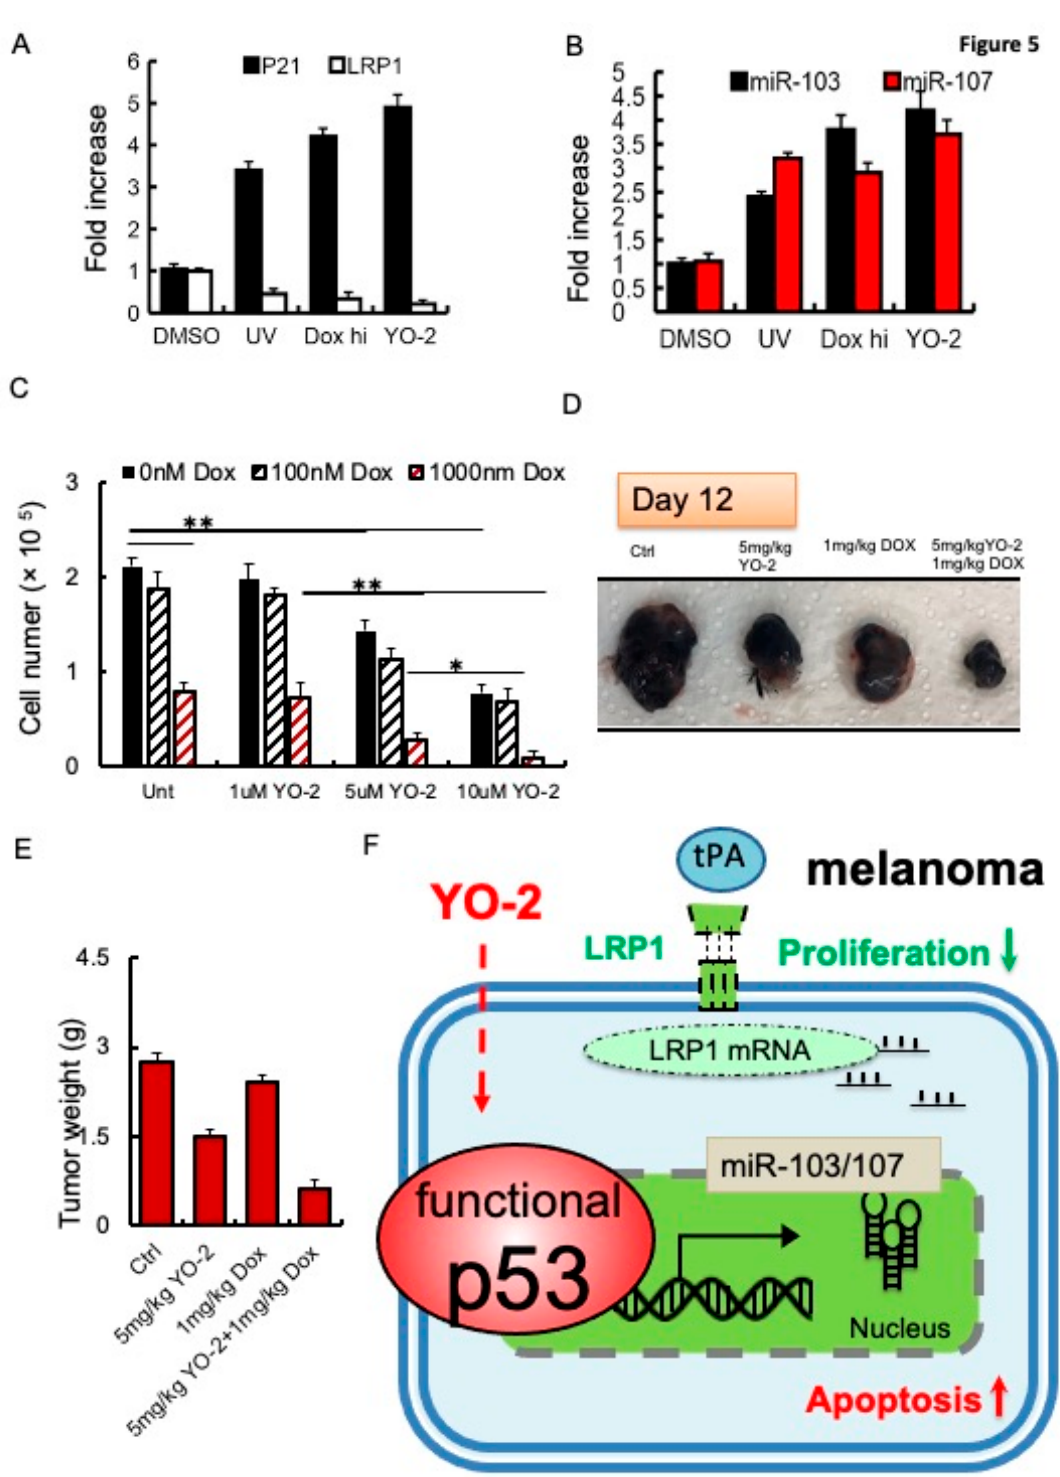
Figure 5. Increased sensitivity of doxorubicin to control tumor growth in YO ‐ 2 ‐ treated tumors. ( A , B ) Fold change in P21 and LRP1 ( A ), and miR ‐ 103 or miR ‐ 107 ( B ) expression in UV ‐ exposed, doxorubi ‐ cin (high) ‐ , and 10 uM YO ‐ 2 ‐ compared to DMSO ‐ treated B16F10 cells ( n = 3/group). We normalized most genes to b ‐ actin. mi ‐ 103 and miR ‐ 107 expression were normalized to U6 gene expression. All data are presented as a relative fold change to controls according to the comparative Ct method (2 −ΔΔ Ct. ) and represented as mean ± SEM, with p values from unpaired Student’s t ‐ test. * p < 0.05, ** p < 0.01. ( C ) The proliferation of B16F10 cells treated with/without YO ‐ 2 in the presence/absence of low (100 nM) and high doxorubicin (1000 nM) ( n = 3/group) as determined by counting cells 24 h after cell plating ( n = 6/group). ( D , E ) B16F10 cells were injected s.c. into the right flanks of C57/BL6 mice. Mice were treated with a single dose of doxorubicin on day 5, and cotreated with/without YO ‐ 2 in the indicated groups every other day starting from day 5. Twelve days after injection, tumor weight was measured ( E ; n = 6/group), and macroscopic tumor images were taken ( D ). * p < 0.05, ** p < 0.01 ( F ) Proposed mode of action for YO ‐ 2 in melanoma: YO ‐ 2 upregulates TP53 (also called p53)